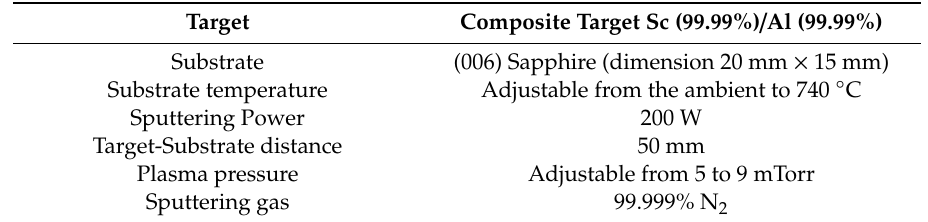
Table 2. Growth conditions.